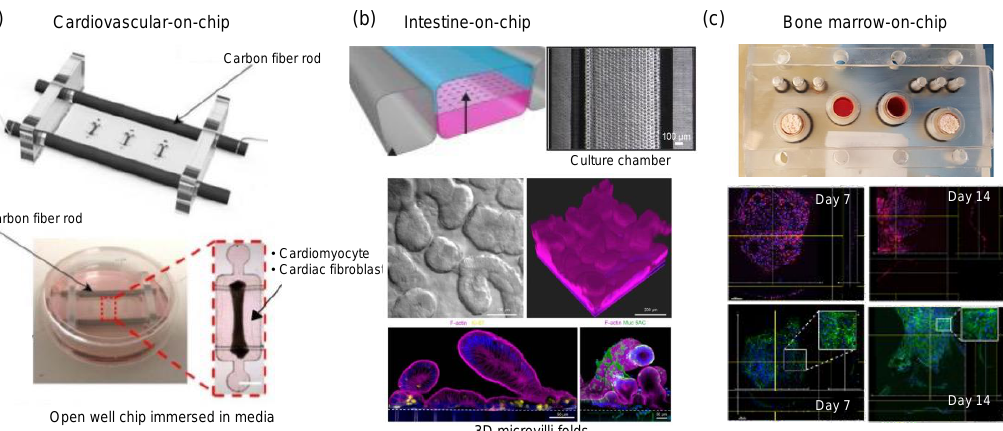
Figure 8. Cardiovascular, intestine and musculoskeletal OoC models. ( a ) Open well OoC device with carbon fiber rods and platinum wires. The voltage applied across the open well tissue culture-induced cardiac contractions. Figure reproduced from Mastikhina et al., 2020 [91]. ( b ) The primary human intestine chip contained human intestinal epithelium and intestinal microvascular endothelium co-cultured while the peristaltic motion was mimicked via an elastic membrane. Figure reproduced from Kasendra et al., 2018 [93]. ( c ) The bone-marrow on-chip model is cultured for up to four weeks under fluid flow. Figure reproduced from Sieber et al., 2018 [100].